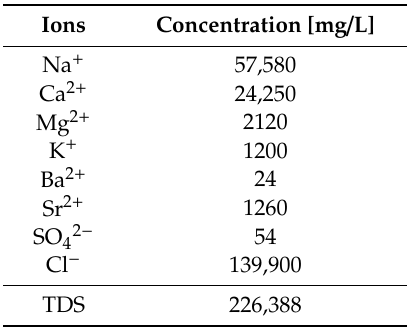
Table 1. Formation brine composition and total dissolved solids (TDS).